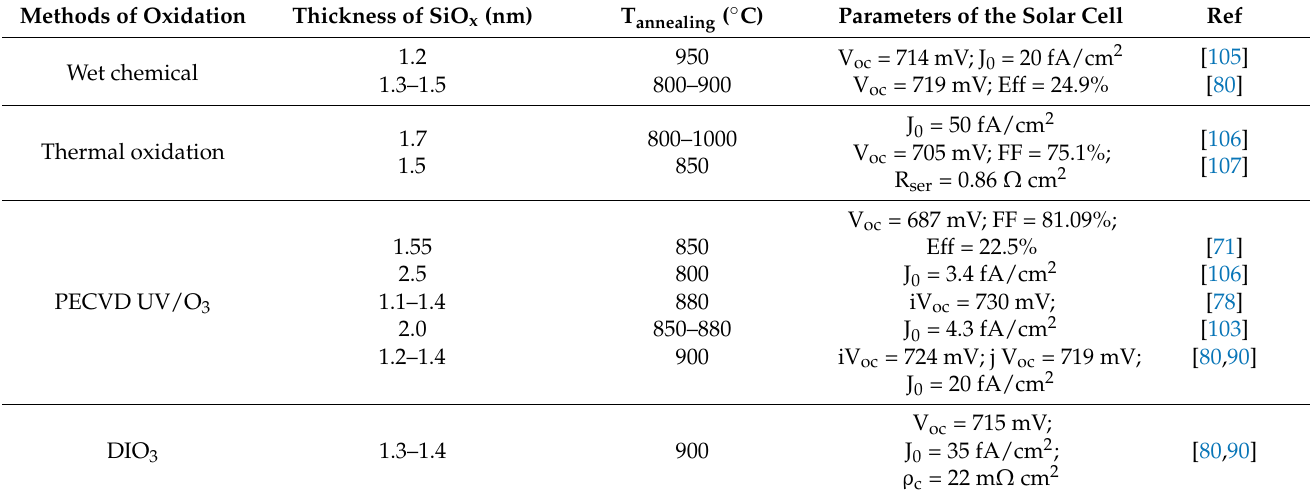
Figure 13. Evaluation n-type TOPCon solar cell from TCAD analysis with conversion efficiency and bifaciality [104]. Table 2. SiO x thickness comparison and different oxidation techniques of cell